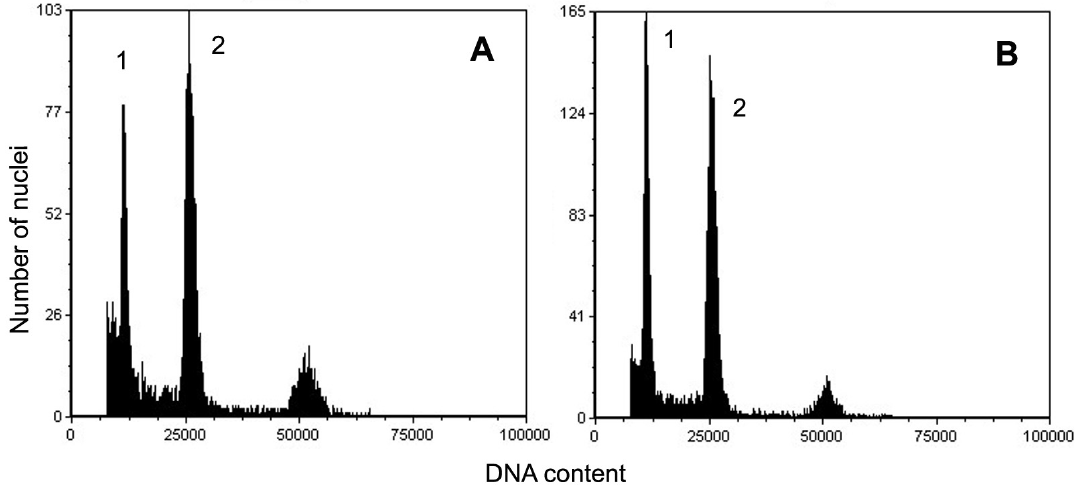
Figure 5. Flow cytometric histograms of nuclear DNA content of Salix myrtilloides . ( A ) plant from natural habitat; ( B ) plantlet produced in vitro. 1—the G 0 /G 1 peak of S. myrtilloides ; 2—the G 0 /G 1 peak of an internal standard ( Solanum lycopersicum ).